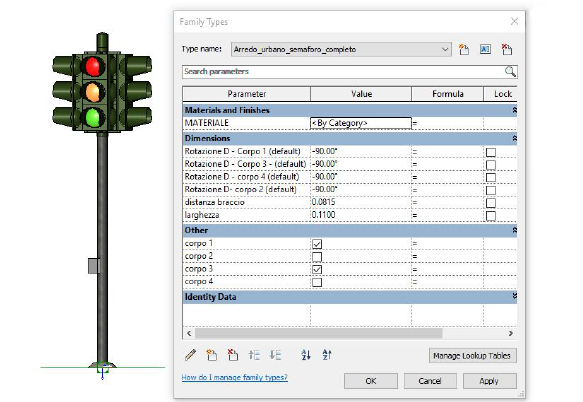
Figure 3. Family of a traffic light with the table of